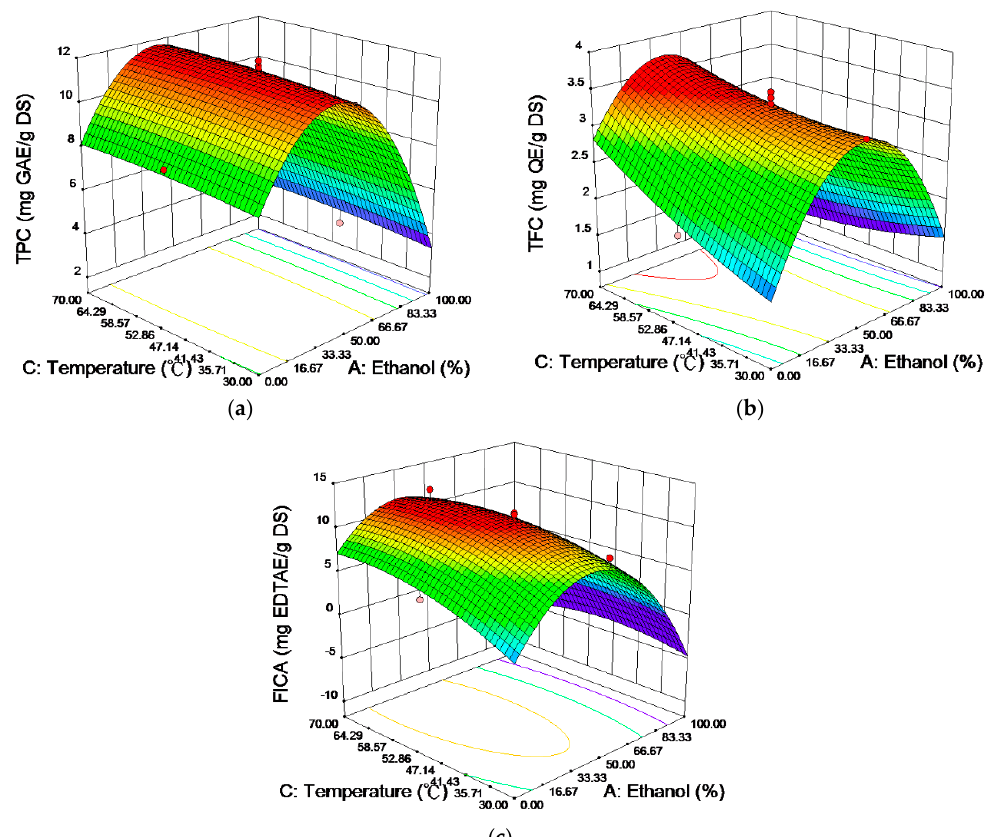
Figure 1. Response surface plots showing the effects of the ethanol concentration and temperature on the ( a ) TPC, ( b ) TFC, and ( c ) FICA.